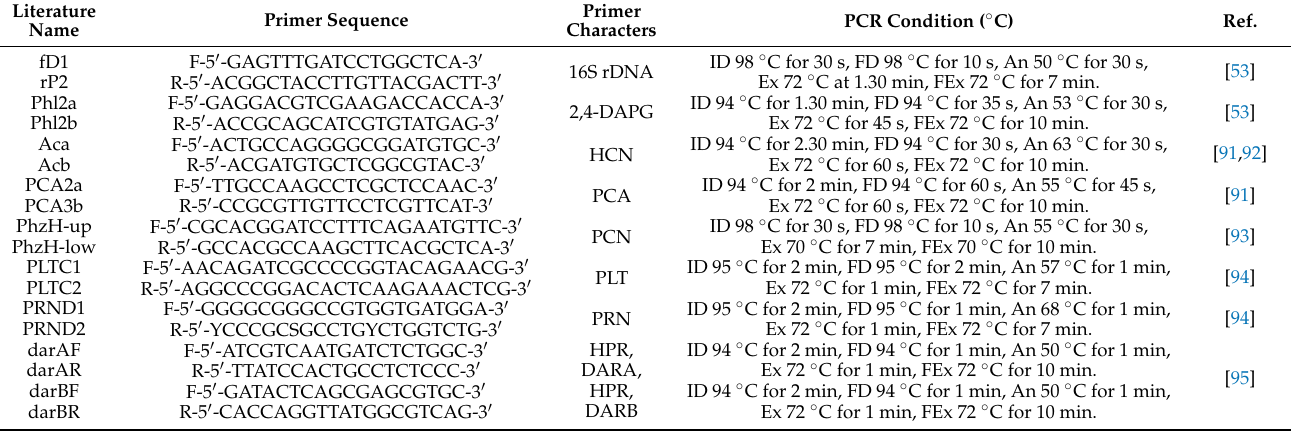
Table 1. List of Primers used for identification of the bacterial isolates and antibiotic